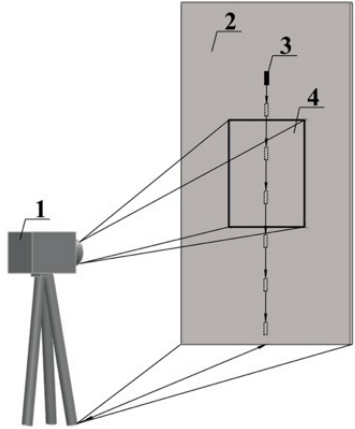
Figure 1. Schematic of the experiment: 1—IR camera, 2—paper screen, 3—particle, 4—detection frame.